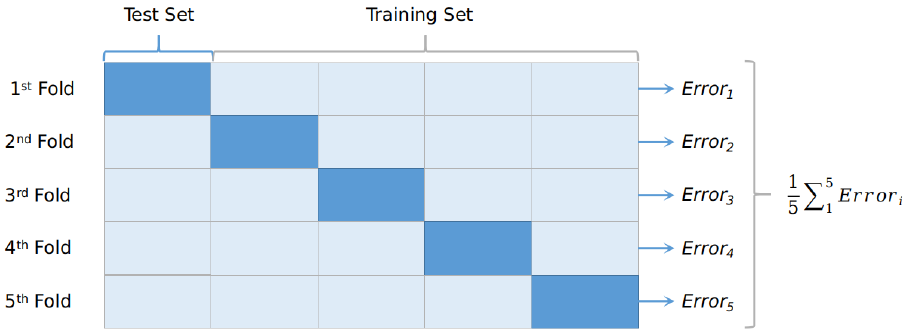
Figure 6. The 5-fold evaluation protocol. At each iteration, 80% of the examinations were considered training sets and the remaining 20% were considered test sets. The average accuracy of all of the iterations was regarded as the model performance.